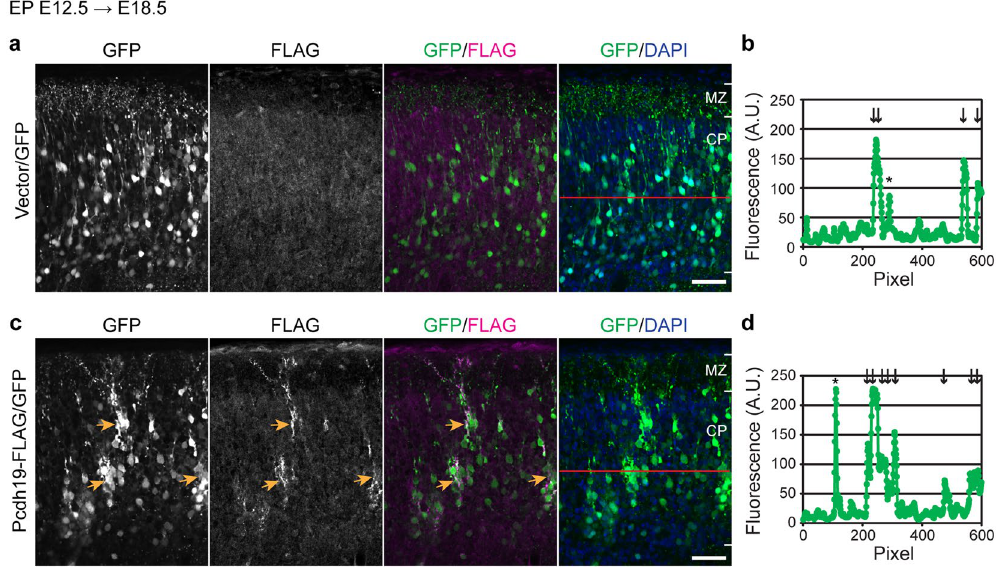
Figure 2. Overexpression of Pcdh19 induces clustering of neurons in the cerebral cortex. ( a – d ) pNeuroD-Cre driven expression of GFP without ( a , b ) or with Pcdh19b-FLAG ( c , d ) in cortical neurons. DNA transfer was performed by in utero electroporation at E12.5. ( a ) GFP-labeled neurons were distributed in the cortical plate. ( b ) Fluorescence intensities along the red line indicated in the rightmost image in a . Arrows indicate GFP- positive cell bodies, and asterisk indicates a neuronal process along the line. ( c ) GFP-labeled neurons expressing Pcdh19-FLAG formed clusters in the cortical plate. ( d ) Fluorescence intensities along the red line indicated in the rightmost image in ( c ). Arrows indicate the GFP-positive cell bodies, and asterisk indicates a neuronal process along the line. Scale bar, 50 μ